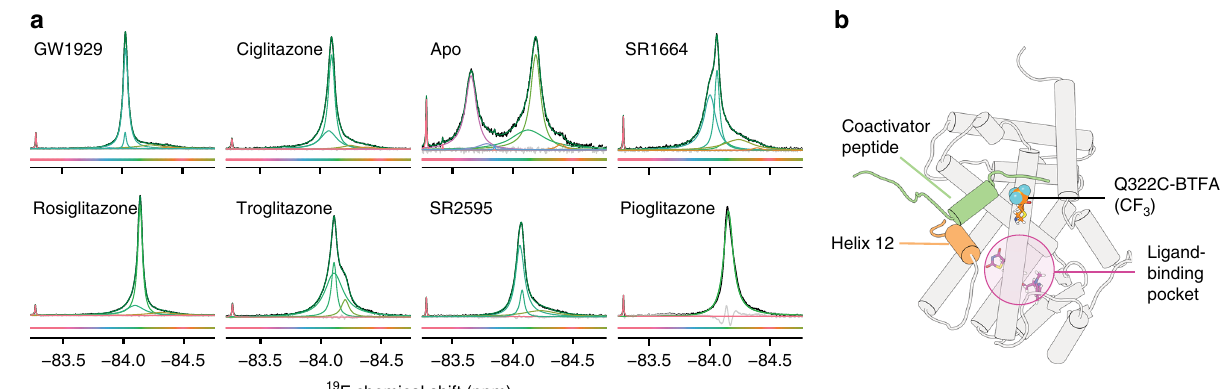
Fig. 4 Agonists reduce the conformational complexity of the co-regulator-binding surface. a Fluorine NMR spectra of PPAR γ C313A,Q322C -BTFA bound to the indicated ligands. The small sharp left-shifted peak in all the spectra is free BTFA. b Trajectory frame from a simulation of PPAR γ C313A,Q322C -BTFA bound to a coactivator peptide (MED1; green) with 322C-BTFA shown in orange as spheres ( fl uorine atoms are turquoise). These experiments were performed